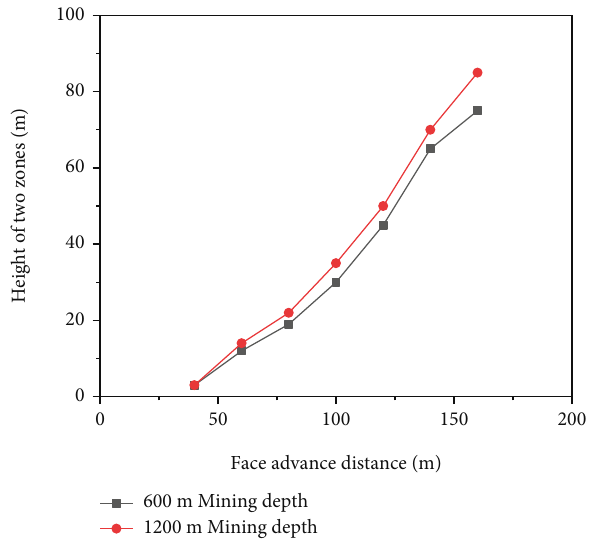
Figure 12: The change rule of the front caving angle with di ff erent advancing distance.